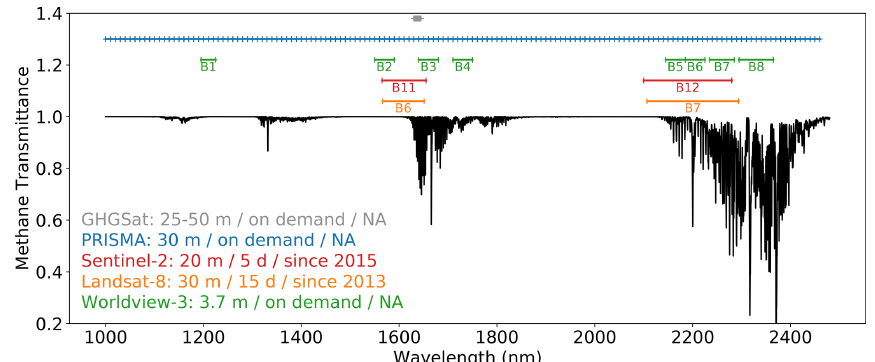
Figure 1. Comparison of the spectral sampling in shortwave infrared of different spaceborne instruments with potential for methane mapping. All of these instruments sample the methane absorption feature around 2300nm. The spatial and temporal sampling characteristics of each mission (spatial resolution, temporal resolution, and temporal coverage) are also